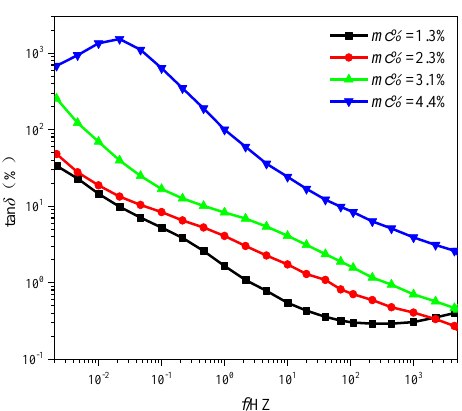
Figure 3. The tan δ curves of unaged pressboards (type I) with various mc% (45 °C) .